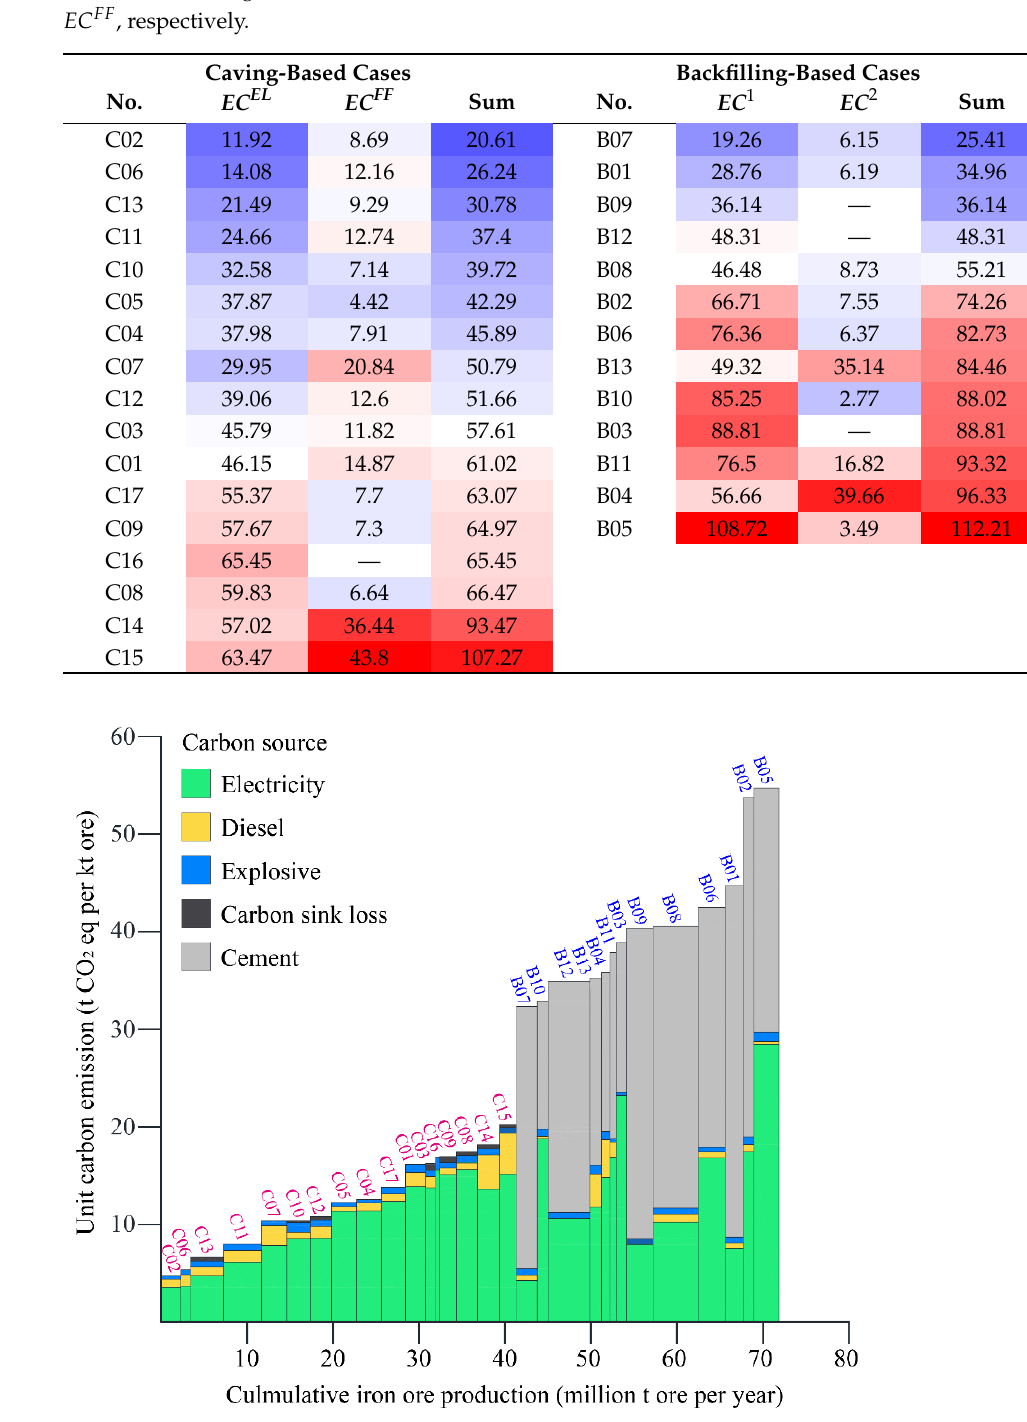
Figure 3. Carbon intensity supply curve of 30 underground iron mines.